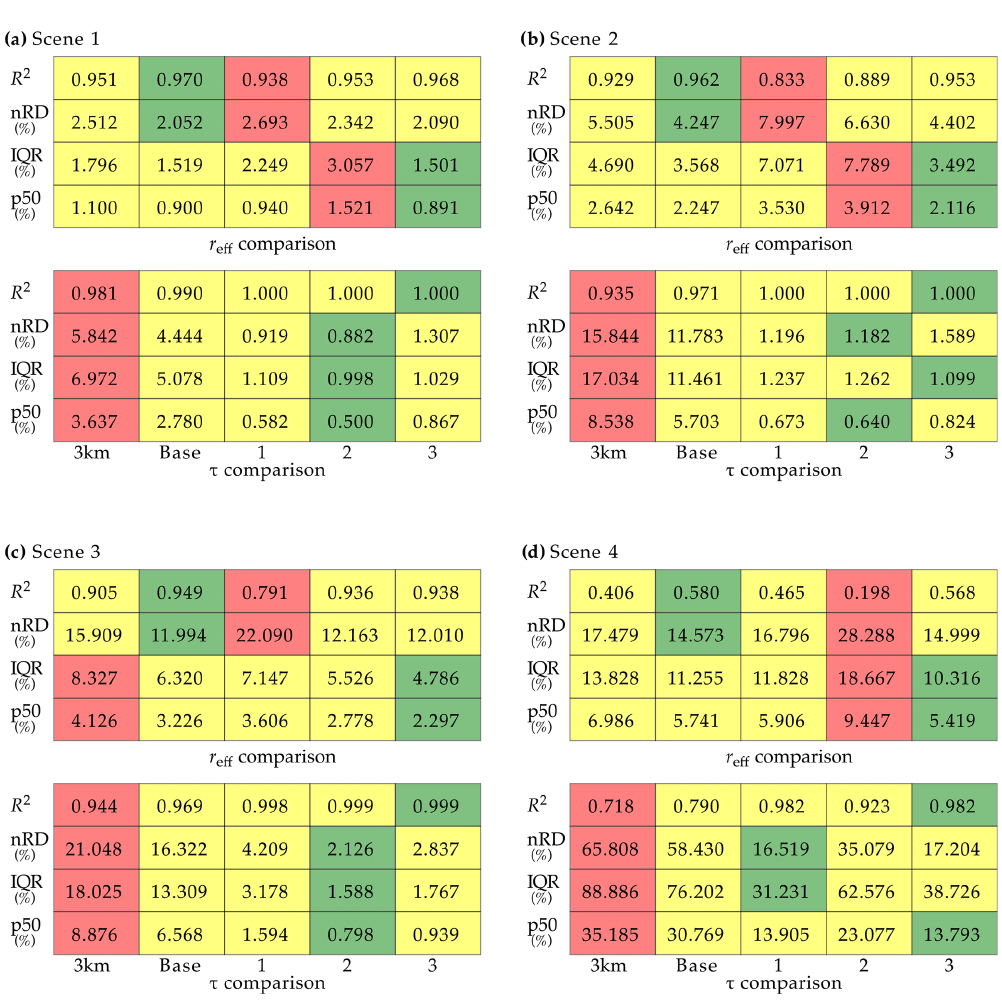
Figure 8. (a) Comparison of retrieved cloud optical thickness ( τ , c , d ) and effective droplet radius ( r eff , a , b ) from the native LRES (at a scale of ≈ 3km) and baseline retrievals (i.e., only accounting for low-resolution reflectance variability), as well as the downscaling experiments 1 (statistical downscaling approach), 2 (constant reflectance ratio approach), and 3 (adjusted lookup table approach with LUT slope adjust- ment), and the reference retrieval results. Parameters to quantify the comparisons are the median of the relative difference to the reference (p50), relative interquartile range (IQR; 75th–25th percentile of the relative difference to the reference), normalized root-mean-square devi- ation (nRD; defined as the RD between the two data sets, normalized by the average reference retrieval), and the explained variance ( R 2 ). Green colors indicate the experiment that compares best to the reference results, i.e., highest R 2 and lowest p50, IQR, and nRD. Red colors indicate the experiment with the worst agreement with the reference retrievals, while yellow colors indicate all experiments in between. Data are from example scene 1 sampled on 1 June 2013 at 10:05UTC. (b) – (d) Same as (a) but for example scene 2 to 4,